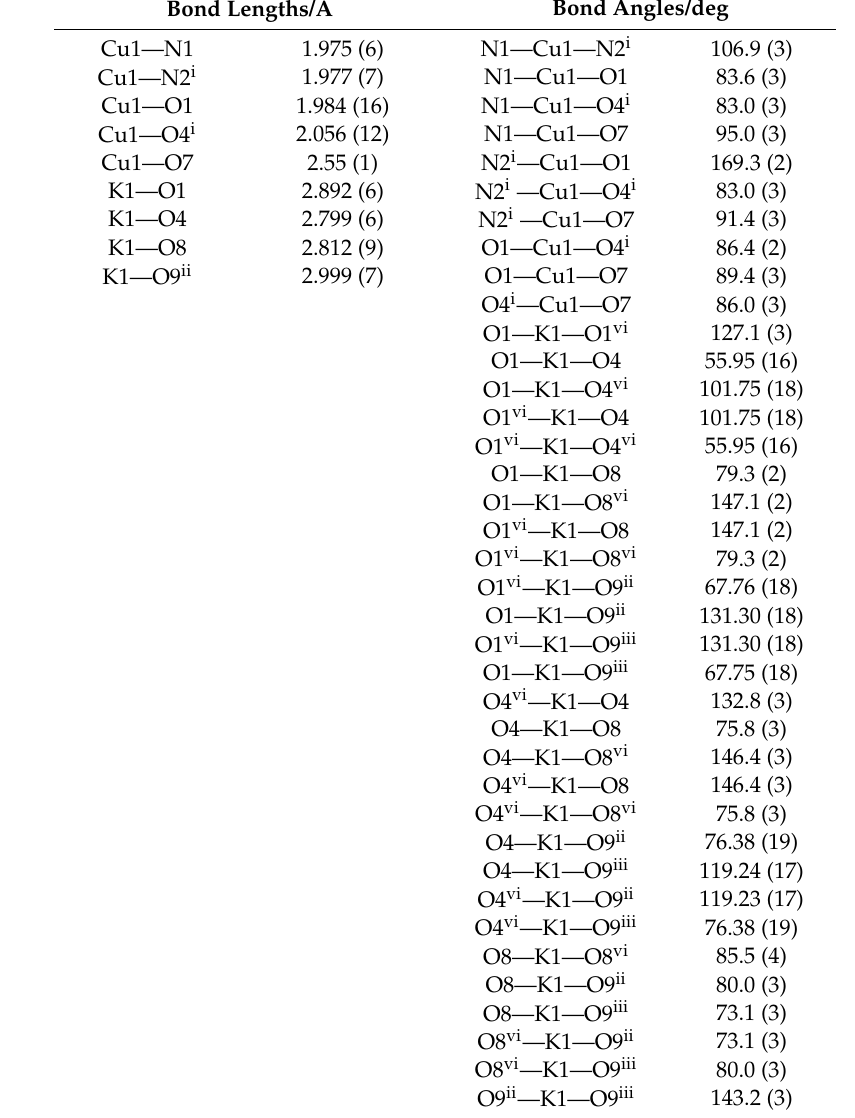
Table 3. Main Bond Lengths (Å) and Angles (deg) for 2 a